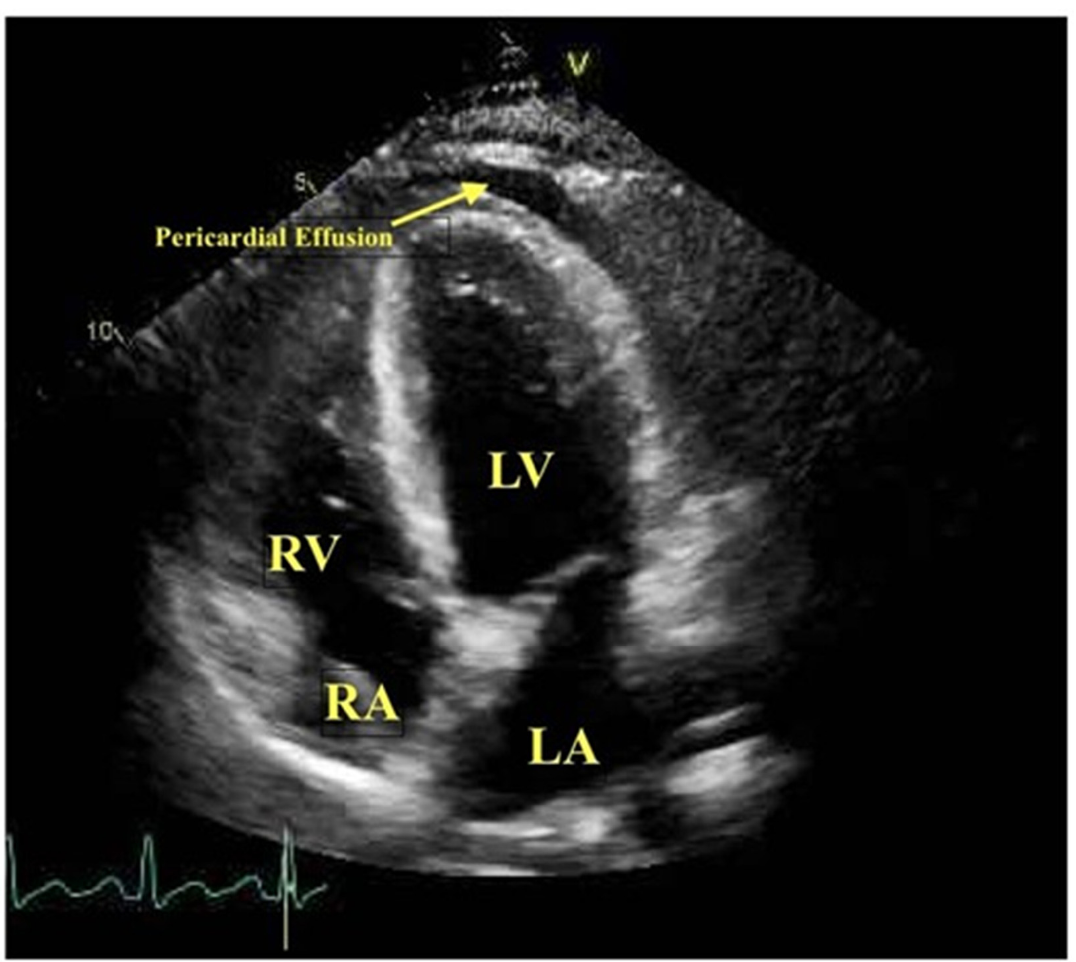
Figure 4. Four-chamber view of transthoracic echocardiogram of a 30-year-old female presenting with cardiogenic shock secondary to COVID-19 myocarditis. The ejection fraction was reduced at 45% with moderate diffuse hypokinesis, grade I diastolic dysfunction, and pericardial effusion. Reprinted with permission from Oxford University Press